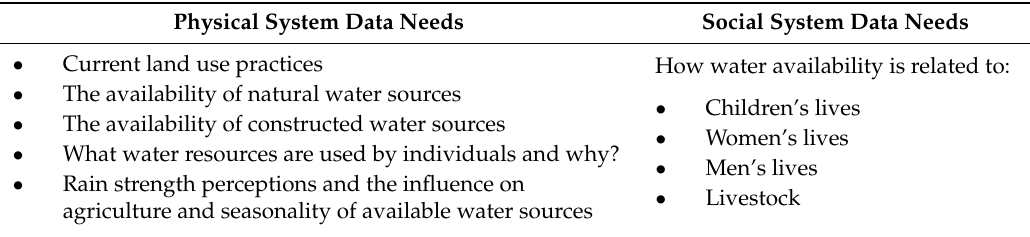
Table 1. Breakdown of workshop data collection